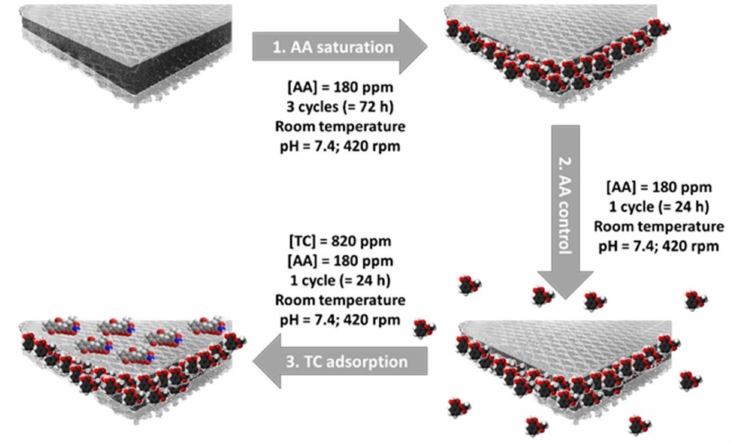
Figure 10. Double adsorption protocol on ACC/CDA composite